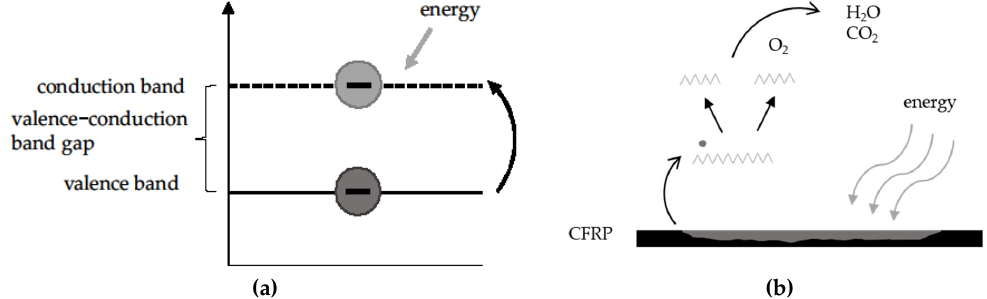
Figure 1. ( a ) Electron jump from the valence band to the conduction band via the addition of energy and ( b ) depletion of the matrix by energy, resulting in the production of water and carbon dioxide. CFRP: Carbon-fiber-reinforced plastic.